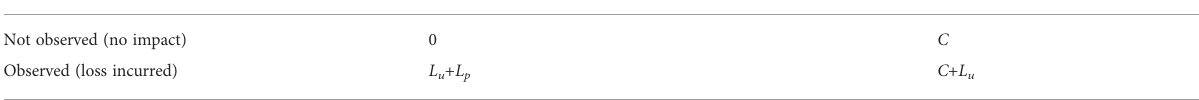
TABLE 1 Framework for evaluation of forecast